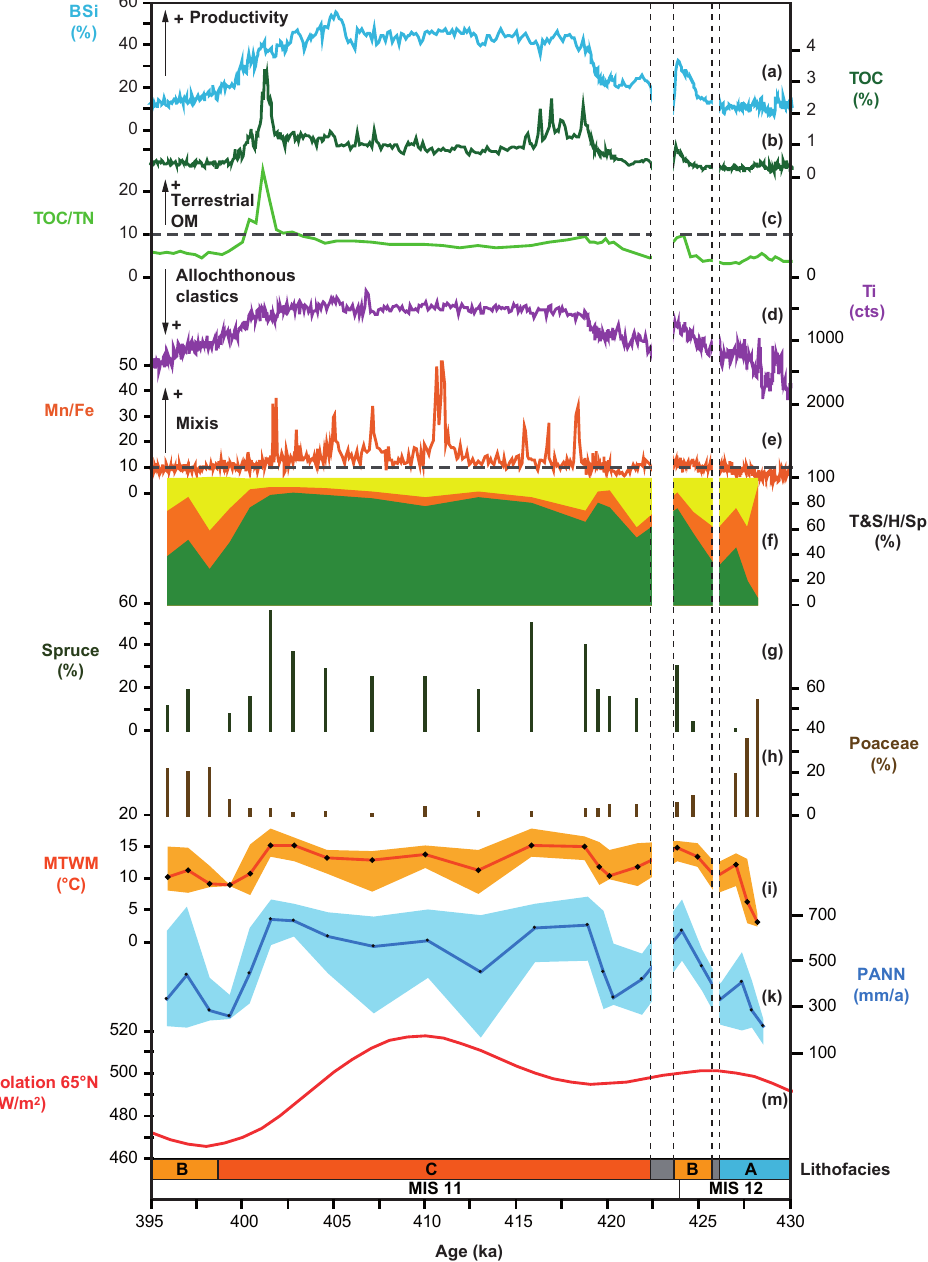
Fig. 3. Indicators for climate and environmental change at Lake El’gygytgyn between 430–395 ka covering the MIS 12/11 transition and full interglacial conditions of MIS 11c. (a) FTIRS inferred biogenic silica (BSi) concentrations; (b) FTIRS inferred total organic carbon (TOC) concentrations; (c) total organic carbon/total nitrogen (TOC/TN) ratio; (d) Ti counts (cts); (e) Mn/Fe ratio (Melles et al., 2012); (f) percentages of trees (T) and shrubs (S; green shading), herbs (H; orange shading), and spores (Sp; yellow shading). The calculation of the group percentages is based on the total sum of pollen and spores taken as 100% (Melles et al., 2012): (g) spruce ( Picea ) pollen percentages calculated upon the terrestrial pollen sum taken as 100% (Melles et al., 2012), (h) grass ( Poaceae ) pollen percentages calculated upon the terrestrial pollen sum taken as 100% (Melles et al., 2012); (i) mean temperature of the warmest month with orange shaded error range (MTWM; Melles et al., 2012); (k) annual precipitation with blue shaded error range (PANN; Melles et al., 2012); (m) summer (June) insolation at 65 ◦ N (Laskar et al., 2004), lithofacies, and MIS 12/11 boundary according to Lisiecki and Raymo (2005). Vertical dashed lines mark the boundaries of disturbed sections. The age model error for an individual date in the respective interval from Lake El’gygytgyn is in the order of 4kyrs (Nowaczyk et al.,